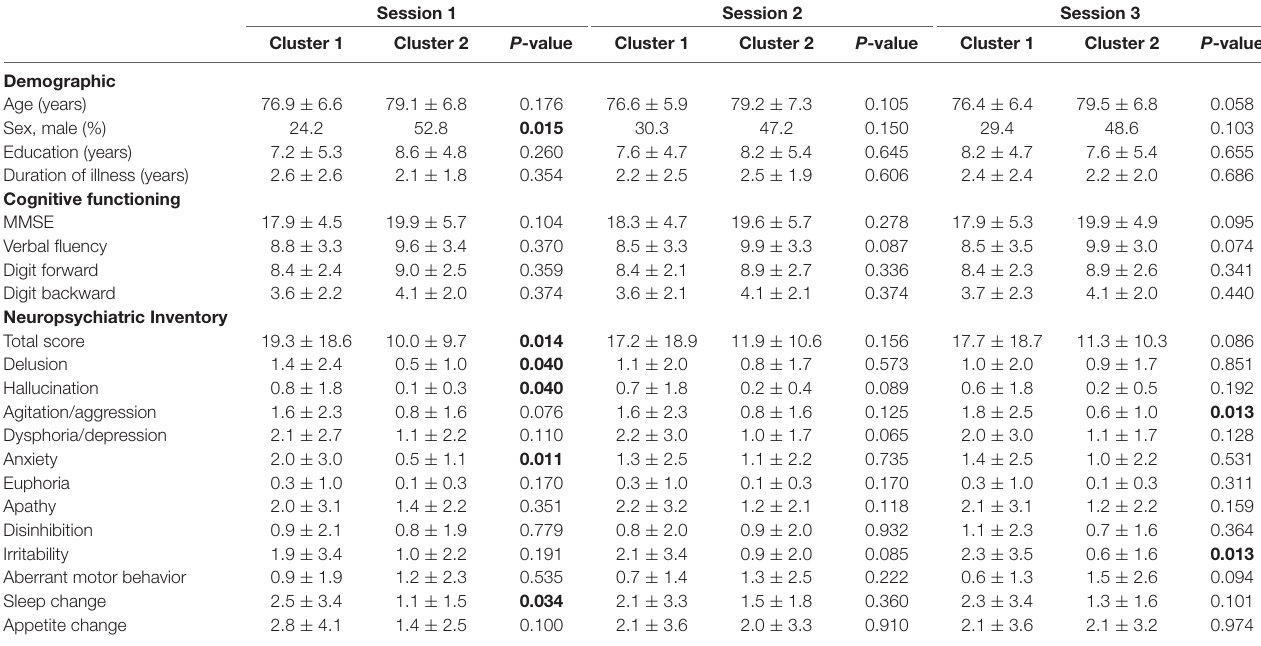
TABLE 3 | Comparison of cognition function and behavioral/psychiatric symptoms between both clusters of patients classified by their EEG powers for the three EEG sessions. Session